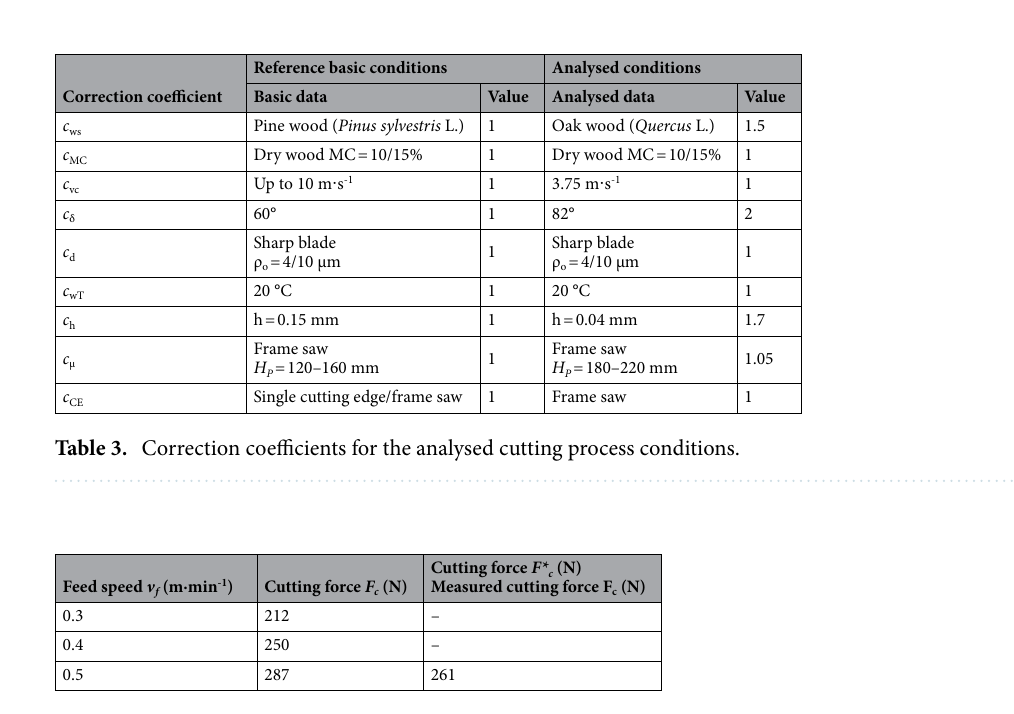
Table 4. Total cutting forces F c computed for the analysed cutting process conditions and corresponding F * c determined experimentally.